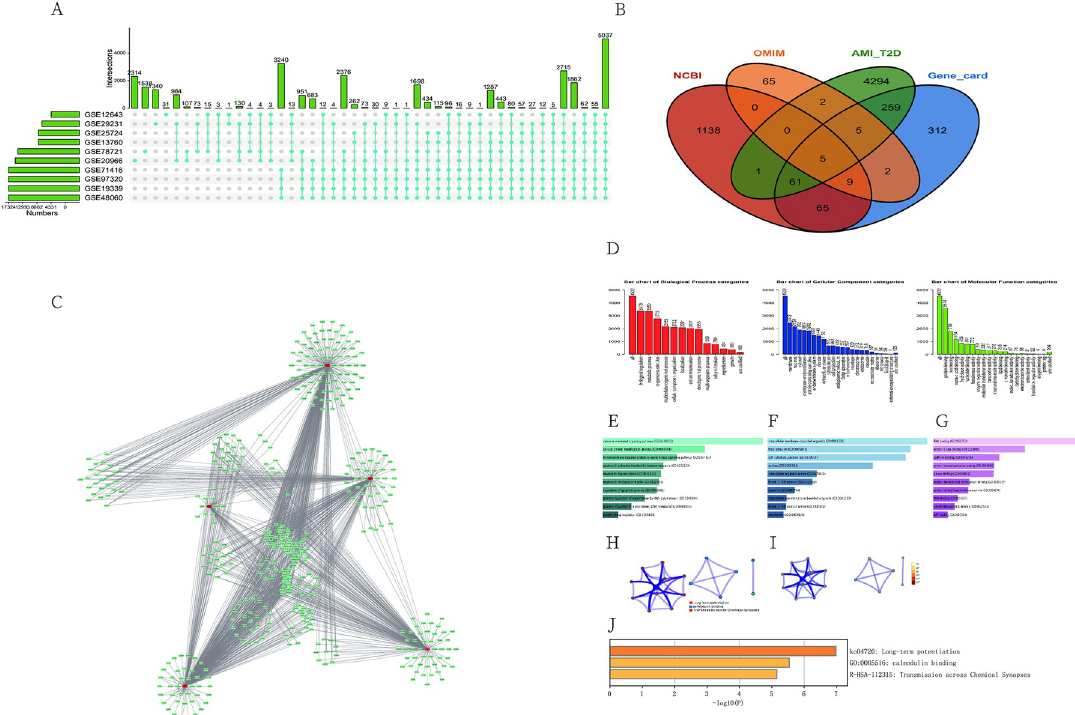
Fig 2. A. UPset plots of the 10 experimental datasets, the blue dots represent the genes in the datasets, the vertical coordinates represent the names of the datasets, and the horizontal coordinates represent the number of genes. Among them, 5037 genes were expressed in all datasets. B. Venn diagram, whose China includes CaMKII-related genes from three NCBI OMIM gene card databases and 4294 differential genes obtained from our analysis using the GEO database. Five genes were common to the four datasets. C. PPI network diagram. Potential upstream miRNAs of 5 critical genes obtained by analysis of the mRNA-miRNA module of the starbase database. D. Molecular function, major cellular components, and biological processes of 5,037 differential genes analyzed by webgestalt database. The main enriched cellular components are the membrane. The primary enriched molecular function is protein binding. The main enriched biological process is biological regulation. E.Bar graphs were obtained from Metascape database analysis. The immediate enriched biological process is cytokine-mediated signalling. F.Bar graphs obtained from Metascape database analysis. The main enriched cellular component is intracellular membrane-bounded organelle. G.Bar charts obtained from Metascape database analysis. The main enriched molecular function is RNA binding. H. Enrichment network map of five critical genes obtained from Metascape database analysis. Notably, the five essential genes were enriched in calmodulin-binding and transmiss on across chemical synapses. I. Enrichment network map of five critical genes obtained from Metascape database analysis. The darker yellow colour represents the higher correlation of the interrelationship of reactions. J. Bar graphs of the five essential genes enrichment obtained from Metascape database